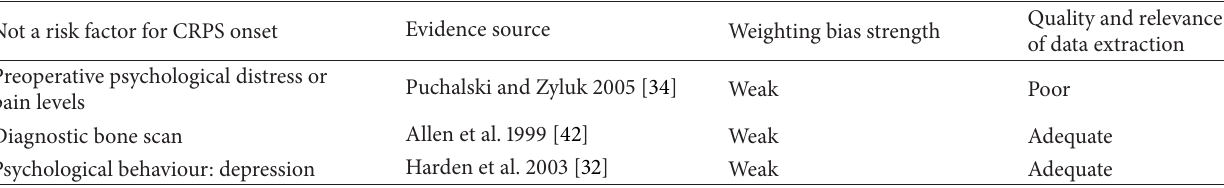
Table 9: Results summary showing factors examined and not found to be risk factors for the onset of CRPS 1 with weighting bias strength and quality and relevance.